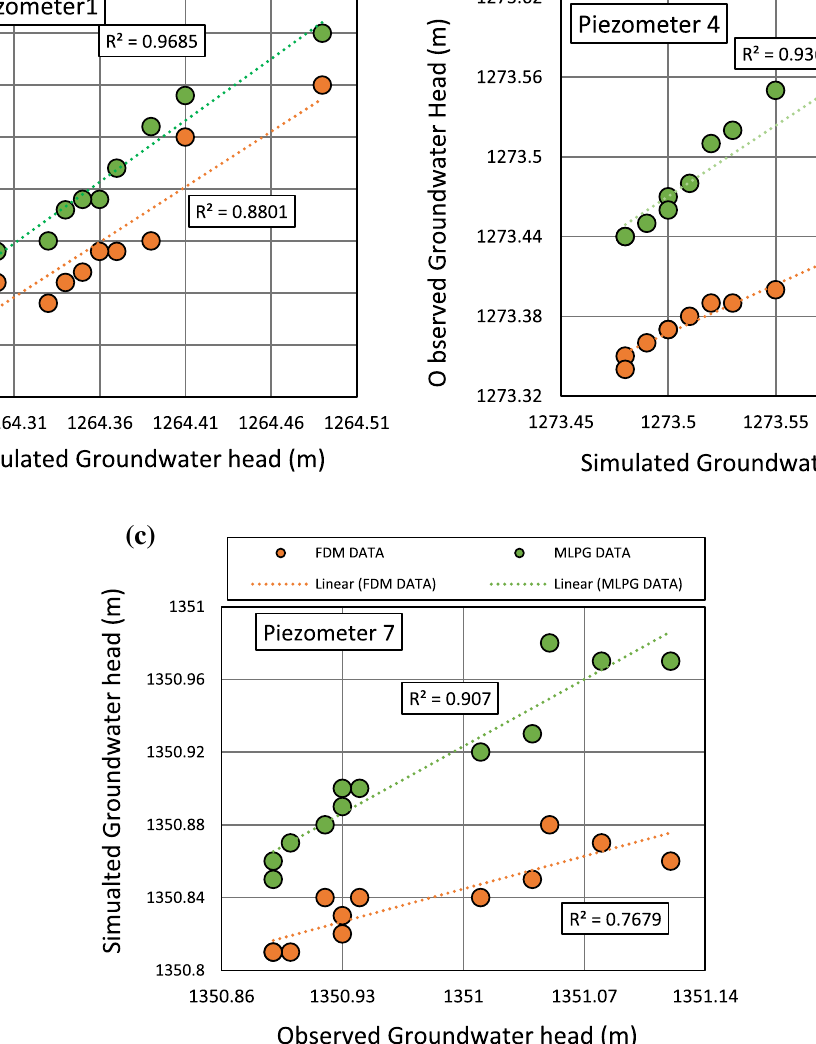
Fig. 8 Computation of regression coefficients for both MLPG-TLBO and FDM